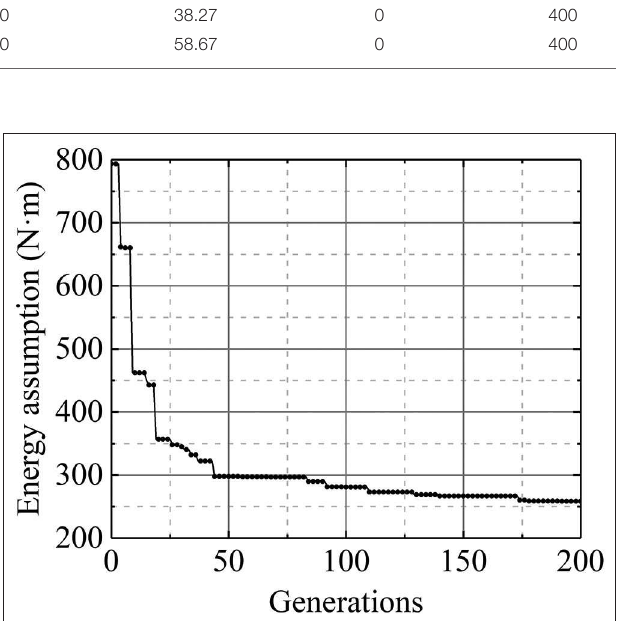
TABLE 2 | Properties of members of the double-layered tri-prism tensegrity system. Type of members Struts